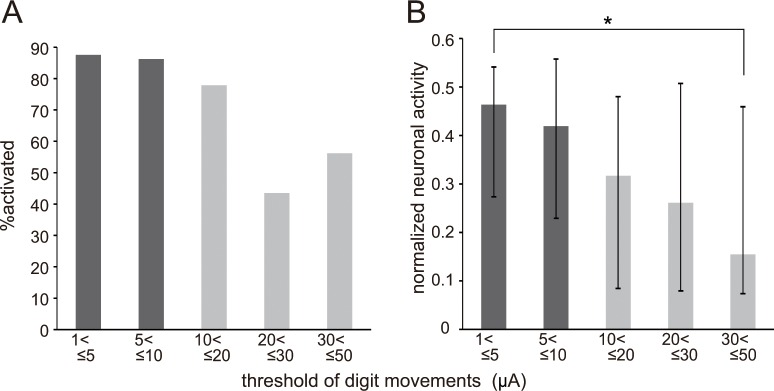
Difference of neural activity among neurons located at recording sites with different movement thresholds for intracortical microstimulation (ICMS).(A) Percentage of neurons in the digit representation of the ICMS map in the primary motor cortex (M1) activated during the grasping phase, 0 to +300 ms from the time of approaching the target (AP), of the precision grip task. (B) The median and interquartile range of normalized neuronal activities in the digit representation in the same period as (A). Both the percentage of activated neurons and normalized neuronal activity decreased as the movement threshold increased. The normalized neuronal activities for different movement thresholds were significantly different (P < 0.05, Kruskal–Wallis one-way ANOVA), and Dunn’s multiple comparisons test showed that the normalized neuronal activity for ≤5 μA was significantly greater than that for ≤50 μA (*P < 0.05). The numbers of neurons for ≤5 μA, ≤10 μA, ≤20 μA, ≤30 μA and ≤50 μA were 23, 40, 26, 22, and 22, respectively.